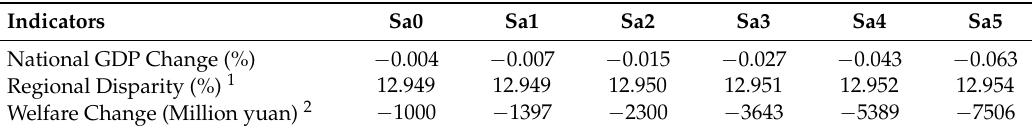
Table 6. Social cost changes under different scenarios.